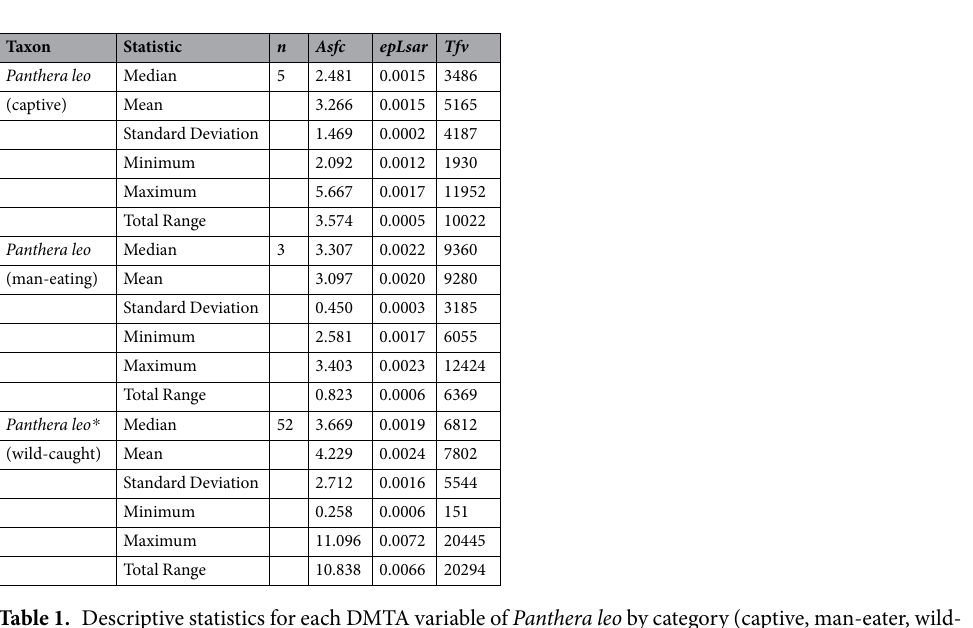
Table 1. Descriptive statistics for each DMTA variable of Panthera leo by category (captive, man-eater, wild- caught). Comparative data of other extant feliforms were published previously 18 . n , number of individuals sampled; Asfc , area-scale fractal complexity; epLsar , anisotropy; Tfv , textural fill volume. All teeth analyzed are lower first molars, per Materials and Methods. * Denotes the inclusion of data (n = 29) from a prior study 18